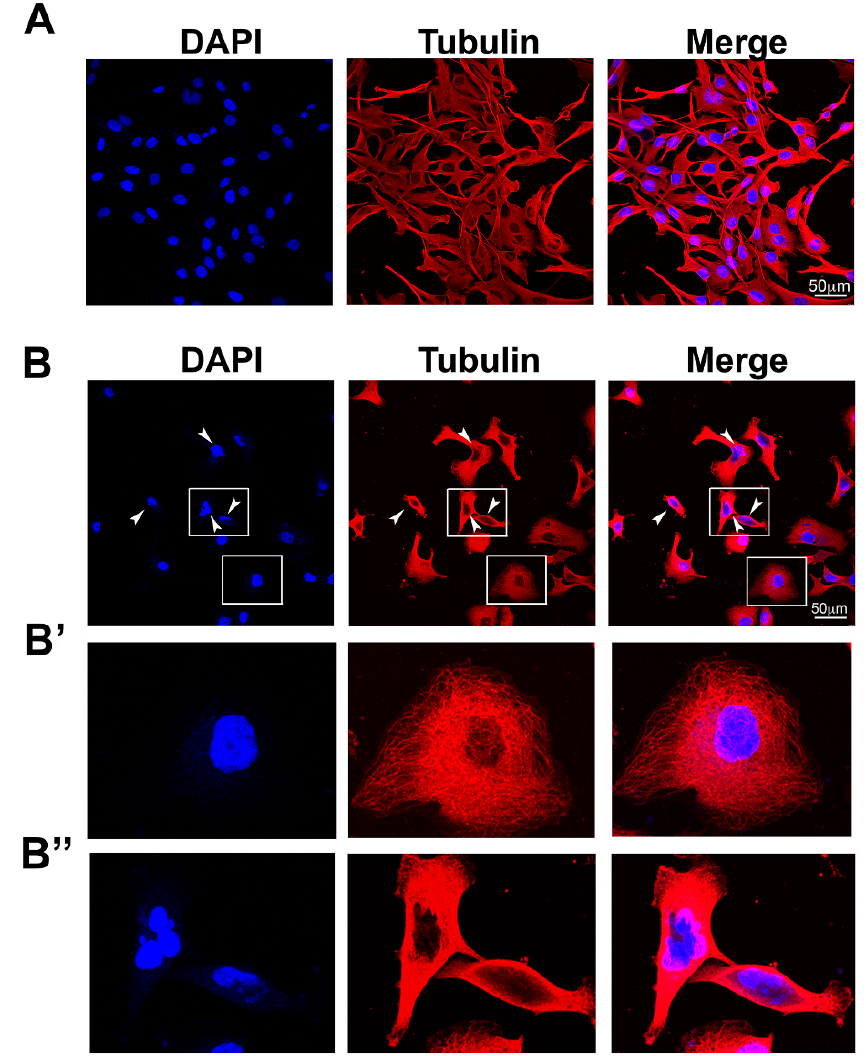
Figure 3. Morphology of A172 control cells ( A ) and A172 cells treated with A. cerefolium methanolic extract ( B ). Boxed regions in B are enlarged in ( B’ ) and ( B’’ ) figures. White arrowheads in B mark cells with multiple micronuclei.